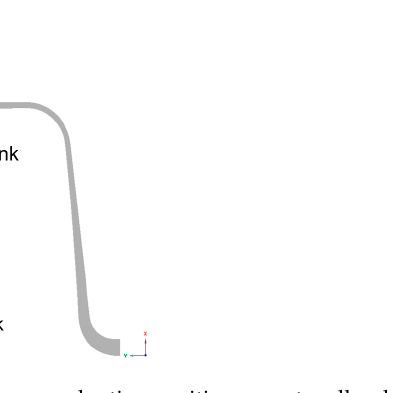
Figure 3. Wall thickness evaluation positions: crest, valley, lower and upper flank.